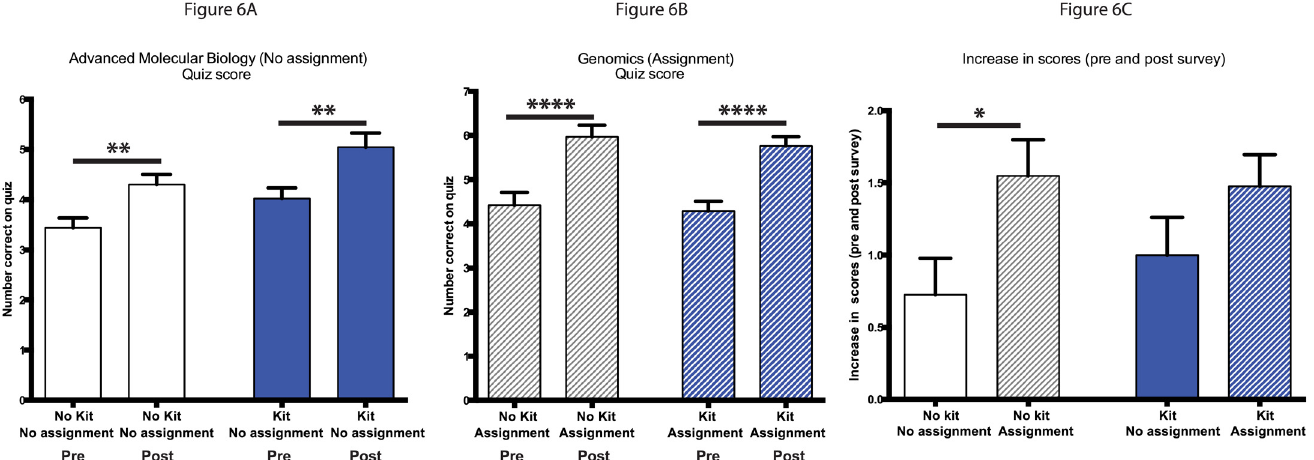
Fig 6. Effect of assignments and kits on student scores on 10-question personal genomics quiz. A) Scores on 10-question personal genomics quiz for students in Advanced Molecular Biology. Students in this class did not have a required homework assignment. The left two columns are the pre- and post- survey results from students who did not receive kits (white); whereas the right two columns are the survey results from students who did (blue). Statistical analysis performed using a paired t-test and all values are mean ± SEM with n = 40 for no kit/no assignment (white), and n = 42 for kit/no assignment (blue) ( ** = p < .01). B) Scores on 10-question personal genomics quiz for students in Genomics. These students had a required homework assignment. The left two columns are the pre- and post-survey results from students who did not receive kits (hatched white); whereas the right two columns are the survey results from students who did (hatched blue). Statistical analysis performed using a paired t-test and all values are mean ± SEM with n = 31 for no kit/assignment (hatched white), and n = 42 for kit/assignment (hatched blue) ( **** = p < .0001). C) The change in scores (increase) between the pre and post tests for each course and group were calculated. In the left two columns were students who did not receive kits. Students who did not have a homework assignment (white) were compared to those that did (hatched white). In the right two columns, all students received kits. Students that did not have a homework assignment (blue) were compared to those that did (hatched blue). Statistical analysis performed using an unpaired Student t-test and all values are mean ± SEM with n = 40 for no kit/no assignment (white), n = 42 for kit/no assignment (hatched white), n = 31 for no kit/assignment (blue), and n = 42 for kit/assignment (hatched blue) ( * = p <